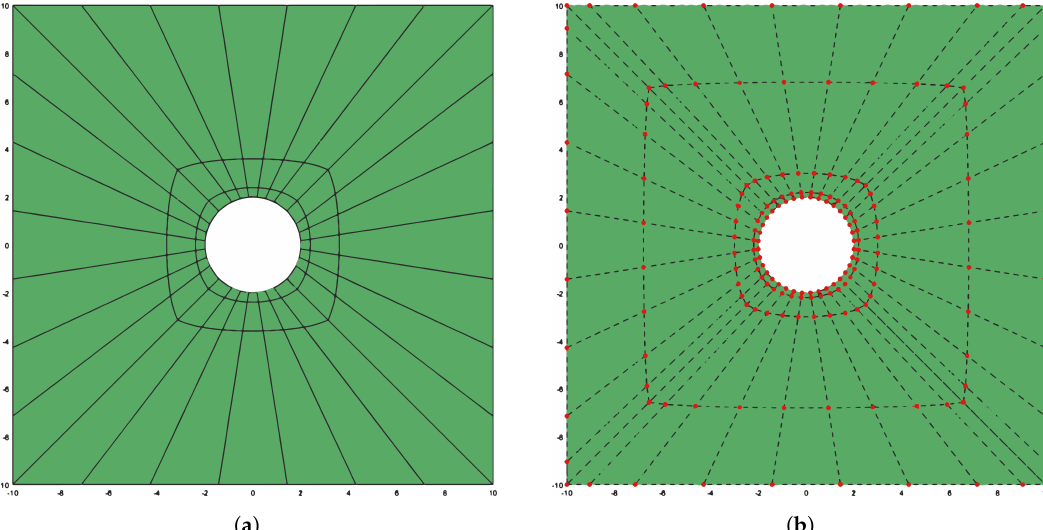
Figure 6. Case 1: physical domain, h 1 -refinement mesh and correspondent control points. ( a ) The physical mesh; ( b ) the control point for the NURBS